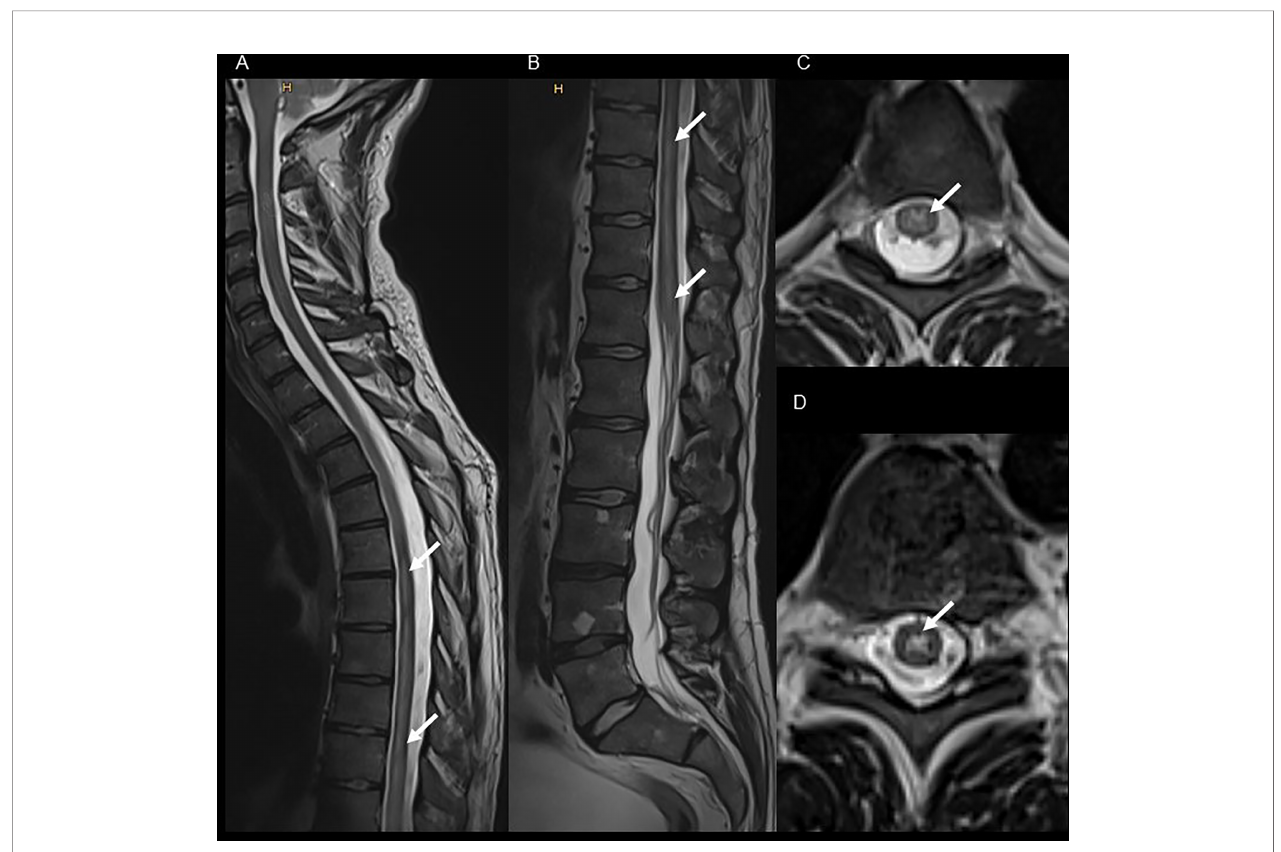
FIGURE 1 | Spinal MRI of the index patient presenting with MOG-IgG associated LETM following VZV infection. T2 weighted cervical, thoracic [panel (A) , sagittal view] and lumbar [panel (B) , sagittal view] spinal cord MRI shows extensive hyperintense lesion from the level T1 to the conus medullaris [panel (C) , axial view of